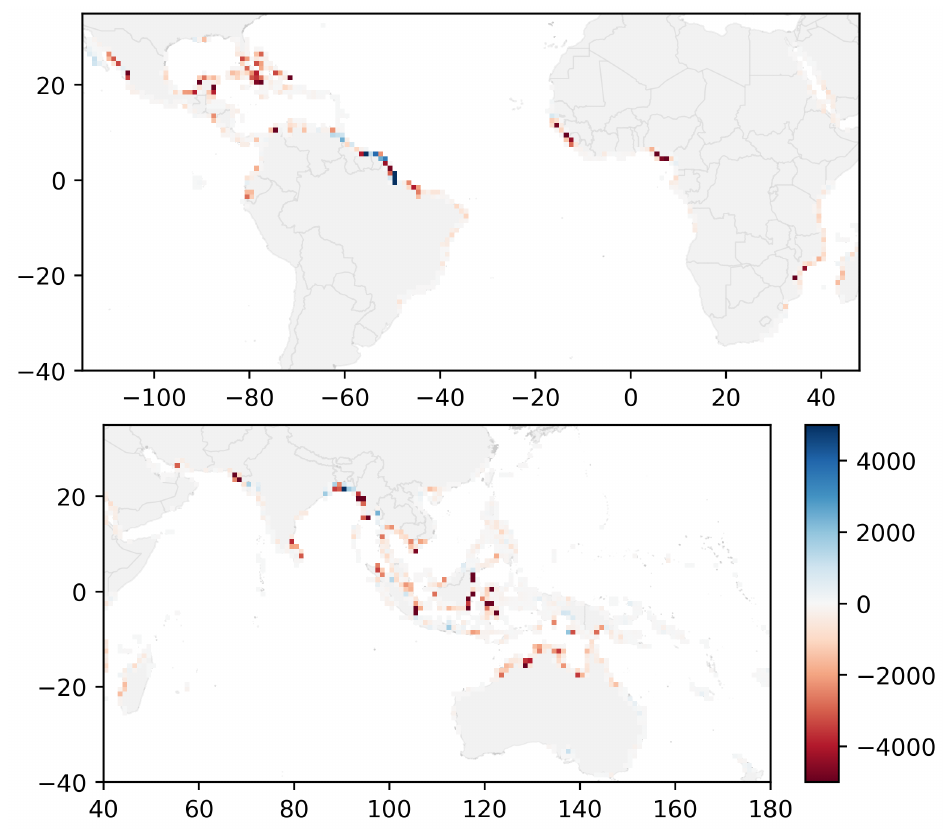
Figure 10. Net change in mangrove extent (in ha) illustrating the locations of mangrove change hotspots on a 1 × 1 degree grid. Areas of red show a net loss while areas in blue a net